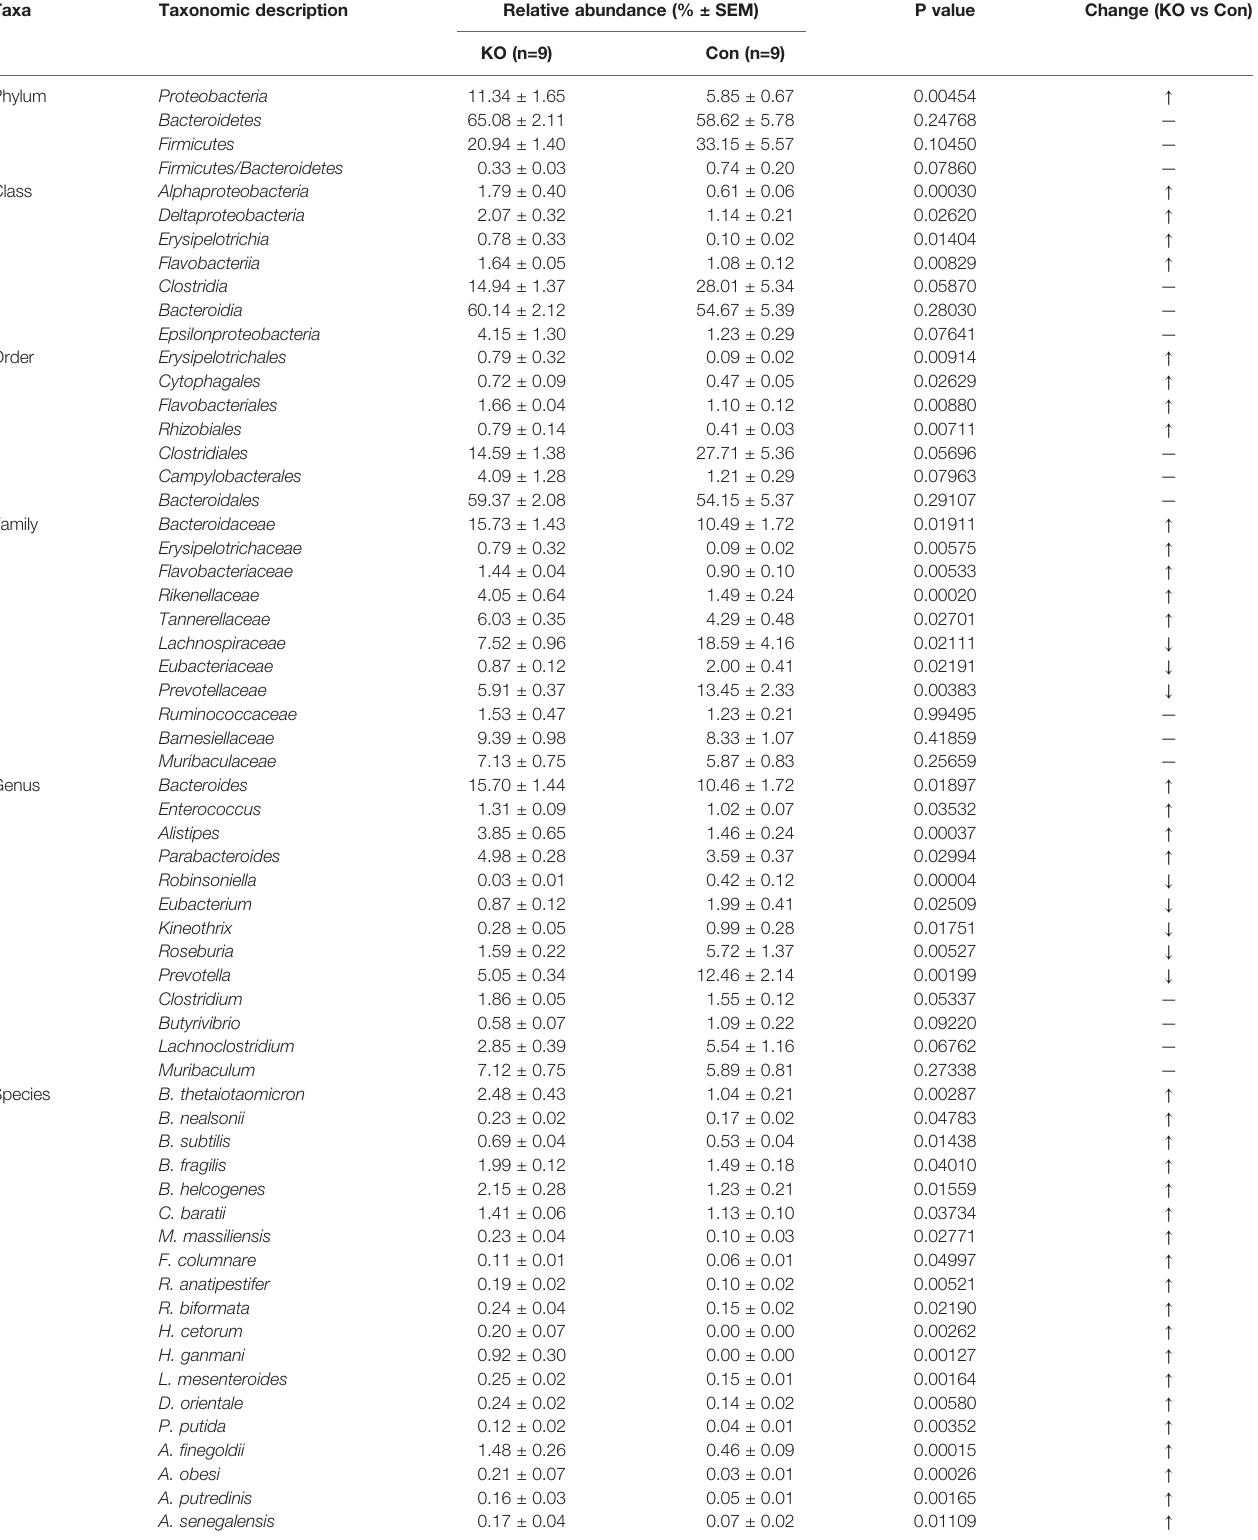
TABLE 1 | Differential abundance of microbiota across taxonomic levels between NHE3 IEC-KO and control